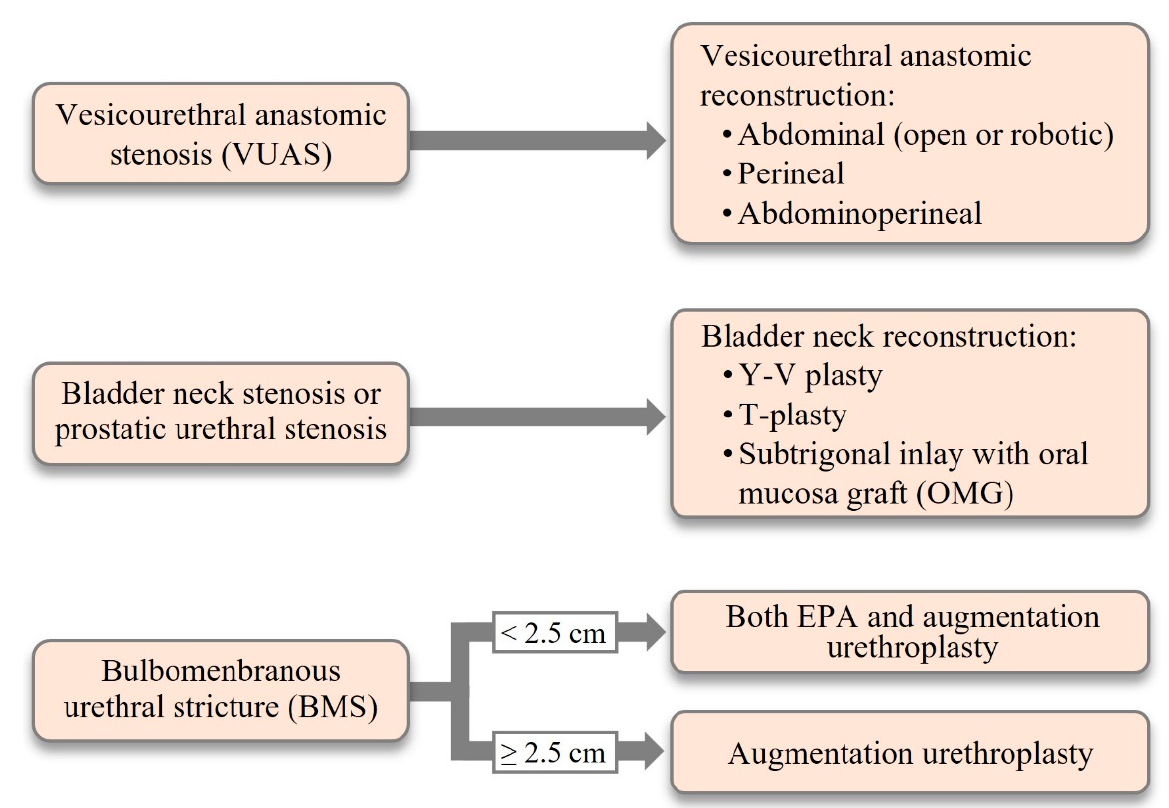
Figure 3. Surgical options for reconstruction of the lower urinary tract due to posterior urethral obstruction in pelvic cancer survivors (Reproduced from EAU Guidelines on Urethral Strictures. European Association of Urology 2021. EAU Guidelines Office, Arnhem, The Netherlands).